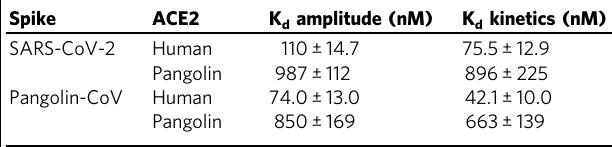
Equilibrium dissociation constants determined from the analysis of the data in Fig. 1 (K d Amplitude)comparedwithvaluesdeterminedfromanalysisofthecorrespondingkineticdata(K d Kinetics) (see Fig.